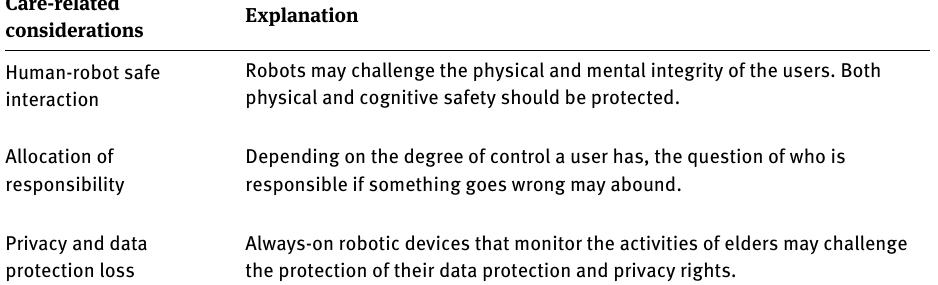
Table 3: Summaries of the main legal and ethical implications of the use and development of robots for care purposes.